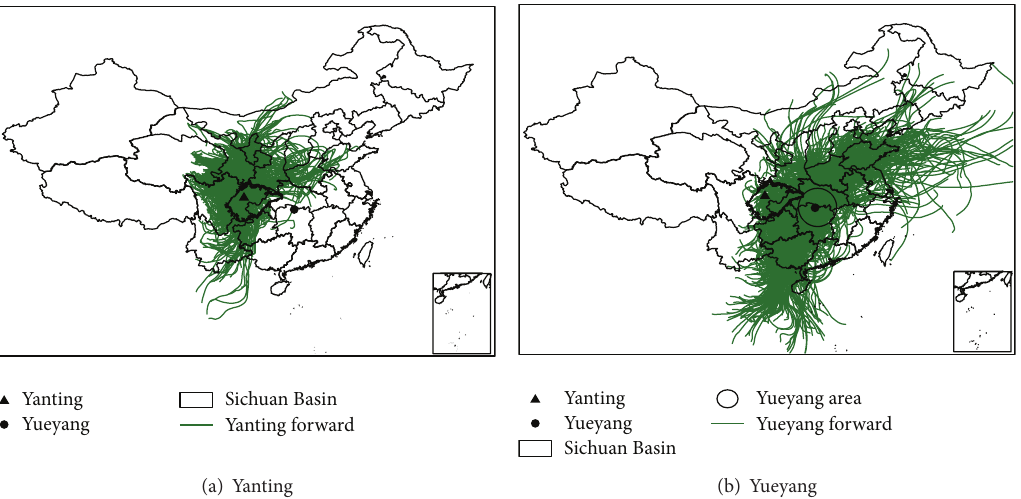
Figure 7: The spatial distribution of forward trajectory simulation from (a) Yanting (solid triangle) in Sichuan Basin and (b) Yueyang area (solid circle).